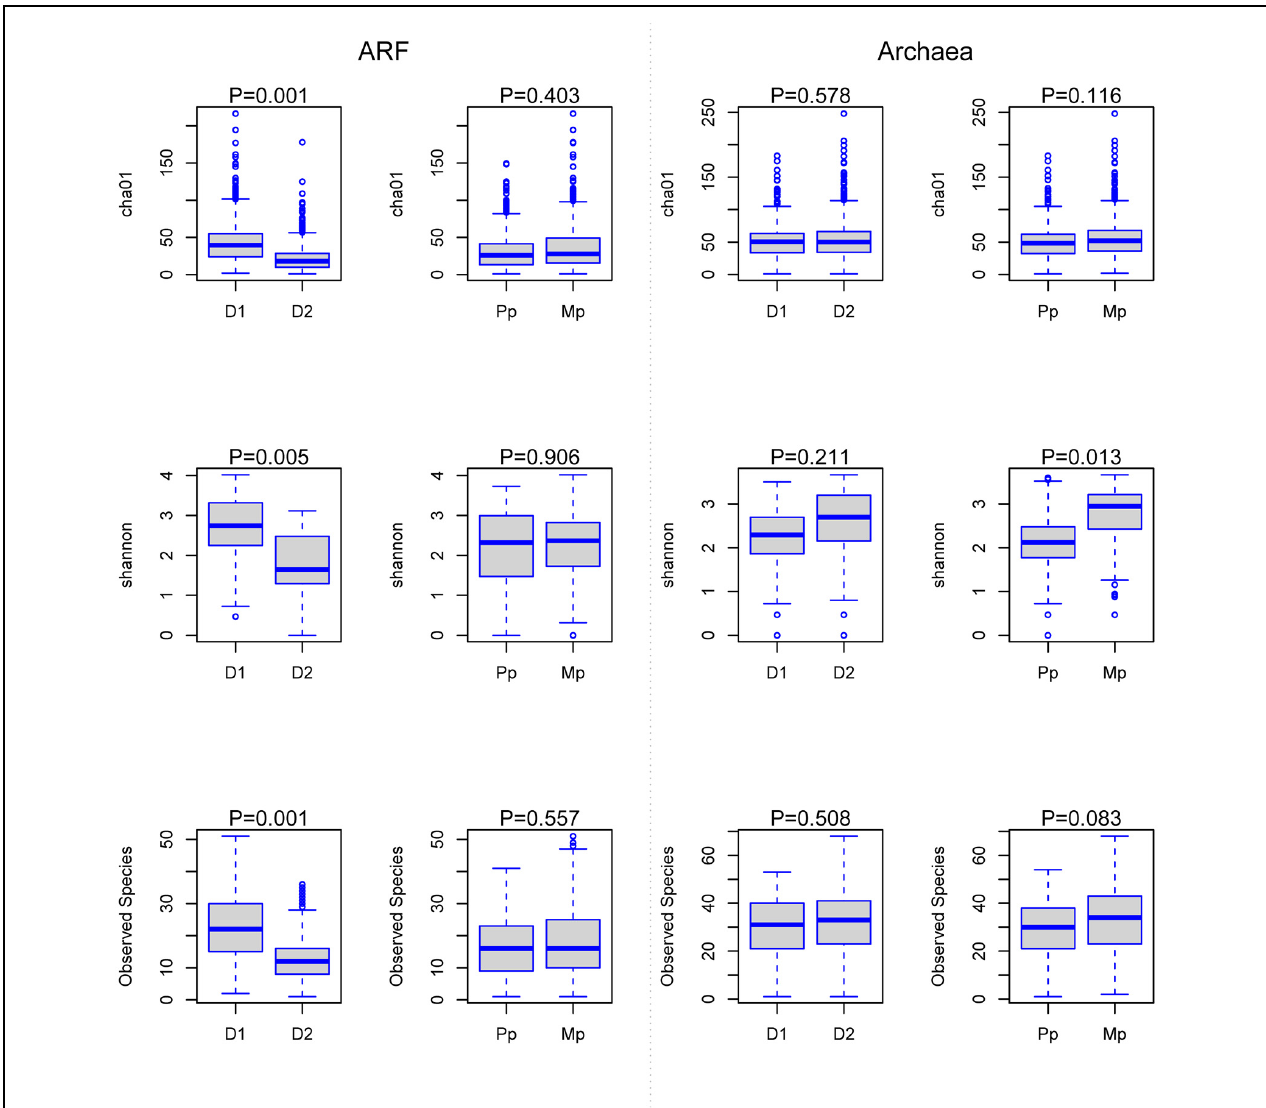
FIGURE 1 | Changes in anaerobic rumen fungi (ARF) and methanogenic archaeal richness, species diversity, and OTUs. Boxes represent the interquartile range (IQR) between the first and third quartiles (25th and 75th percentiles, respectively), and the horizontal line inside the box defines the